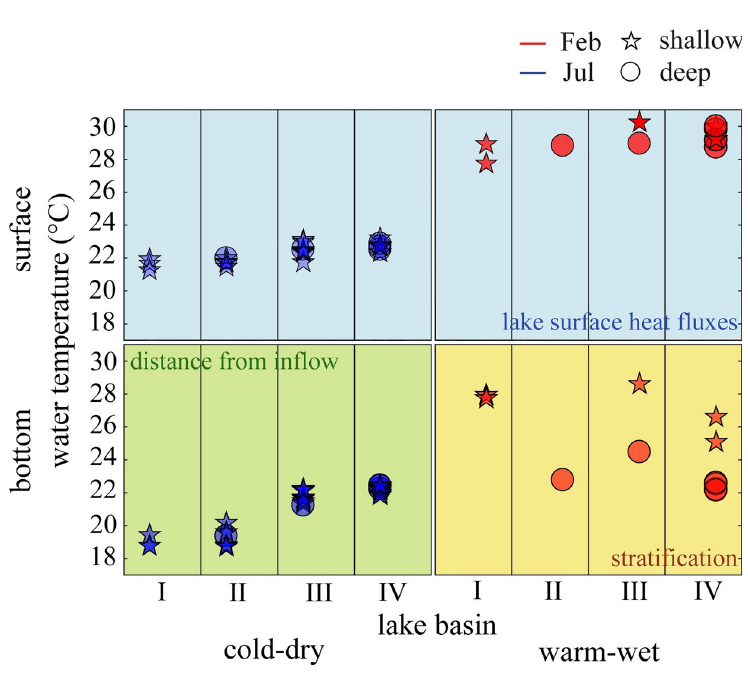
Fig 6. Spatio-temporal analysis of water temperature in Lake Kariba. Stars and circles represent locations where the lake is shallower and deeper than 50 m, respectively. Background colours highlight the different drivers of the lake water